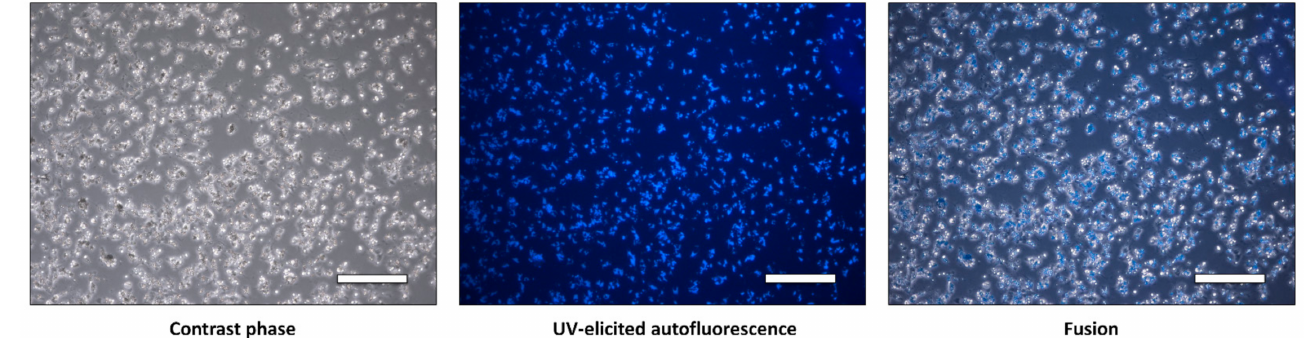
Figure 2. Cytological observation of isolated hepatic stellate cells of HSCs a few hours after plating: contrast phase (lipid droplets are white relative to dark cytoplasm), UV-elicited autofluorescence (blue) and fusion of the first two images. White bar: 200 µ